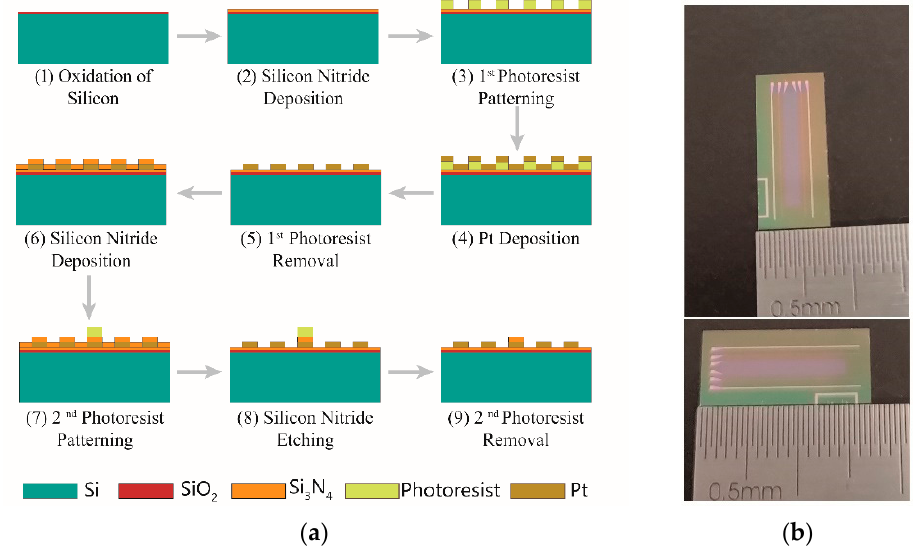
Figure 5. ( a ) The fabrication process of the conductivity sensor chip; ( b ) sixty-one chips, each with a size of 17 mm × 7.5 mm × 0.5 mm, can be fabricated on a 4-inch silicon